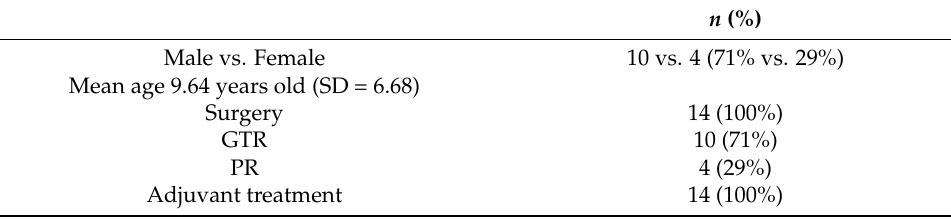
Table 1. Study group details.